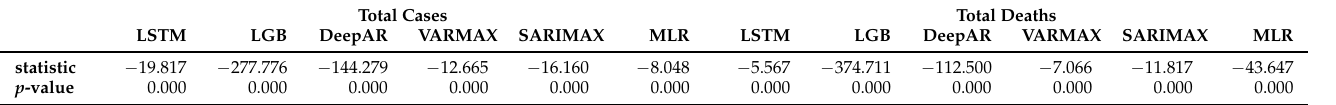
Table 16. Diebold-Mariano test for Forecast accuracy (H 0 : Benchmark Forecasts Outperform MES- Table 15. Student’s t-test for Prediction Interval Coverage (H 0 : Benchmark Prediction Intervals Outperform MES-LSTM).